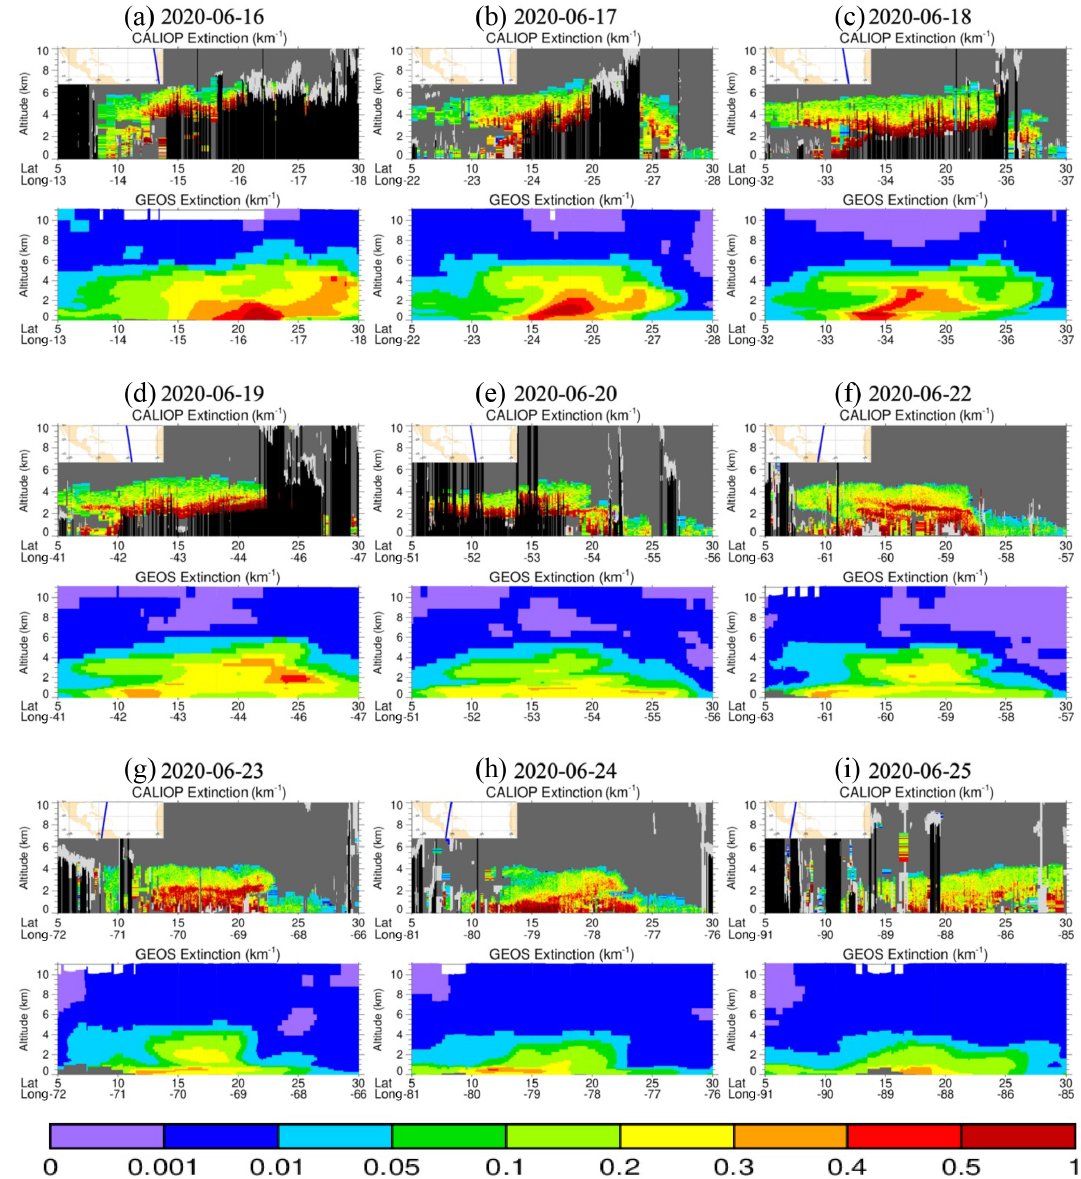
Figure 17. Comparison of altitude–latitude–longitude curtain of aerosol extinction coefficient (km − 1 ) between CALIOP (at 532nm) and GEOS (at 550nm) along the dust plume transit for 9 selected days. GEOS model outputs were sampled along the CALIPSO track shown as the blue line overlying the geographical map (see insets). For CALIOP curtains, the cloudy scene, clear–clean scene, and totally attenuated feature are marked as light gray, dark gray, and black,